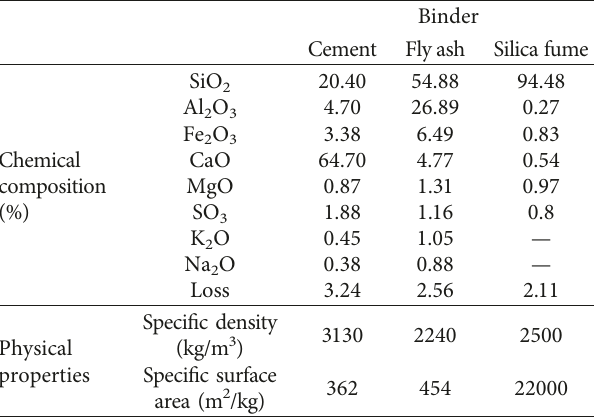
Table 1: Chemical and physical properties of the cement, FA, and SF.